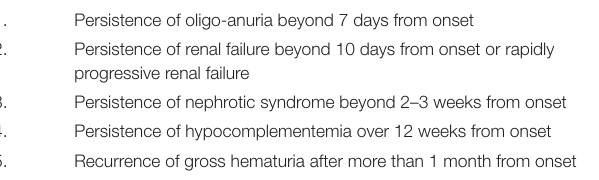
TABLE 2 | Indications for renal biopsy in case of nephritic